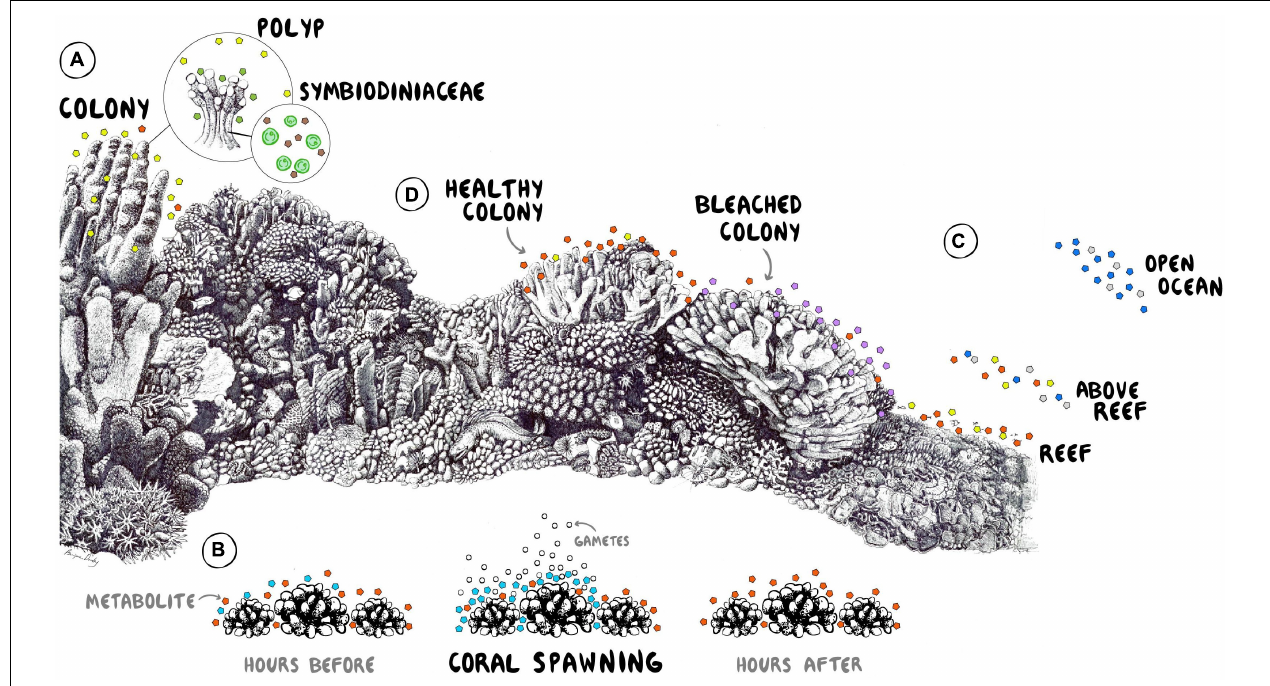
FIGURE 1 | Conceptual illustration of metabolomic studies on coral reefs. (A) Determination of metabolites involved in the recruitment, establishment, and maintenance of symbionts. (B) Identification of chemical signals facilitating spawning synchrony and mating success. (C) Spatial comparisons of exometabolomes across coral reef habitats and the adjacent ocean waters. (D) Characterization of exometabolite stress biomarkers during a warming event. Coral reef drawing by Ben Darby. Graphic design by Shayle